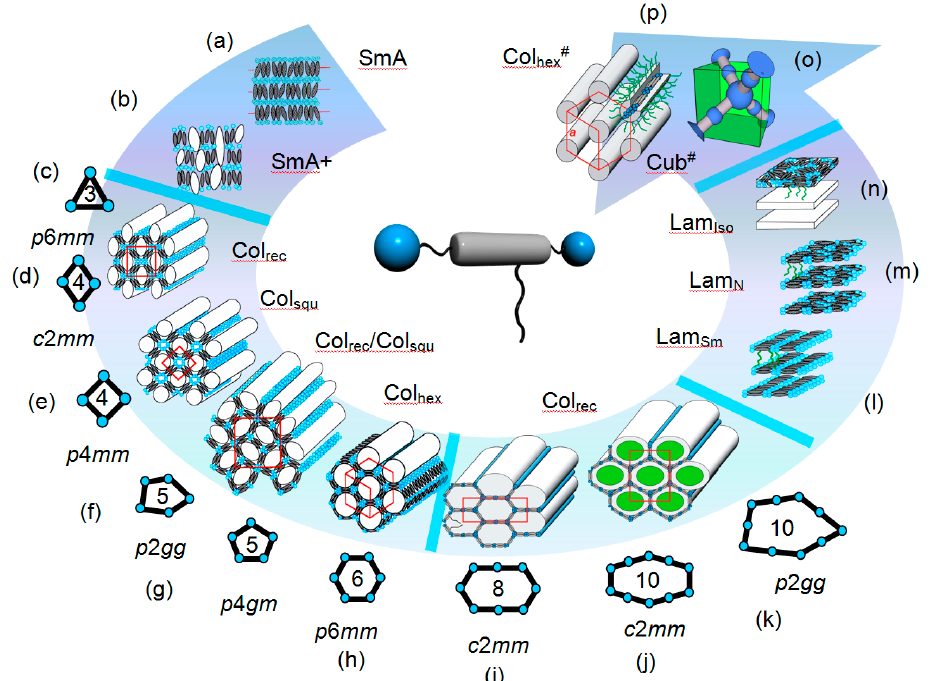
Figure 1. Liquid crystalline self-assembly of T-shaped bolapolyphiles. Besides the smectic phases ( a , b ) and the small polygonal honeycombs with triangular and quadrangular shape ( c – e ), considered here, also larger pentagonal and hexagonal honeycombs ( f – h ), giant honeycombs formed by end-to-end connected pairs of molecules ( i – k ), special types of lamellar phases with coplanar rod alignment ( l – n ), as well as cubic network phases ( o ) and columnar phases involving coaxial rod-bundles ( p ) are known [15,17].